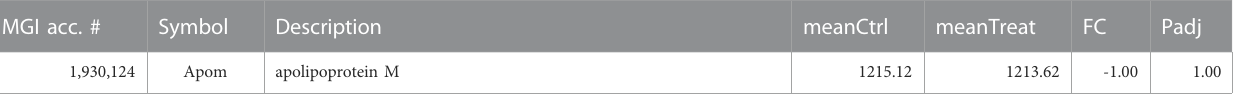
TABLE 1 ( Continued ) Expression levels of genes with relevance to lipid transport and processing. MGI acc. #